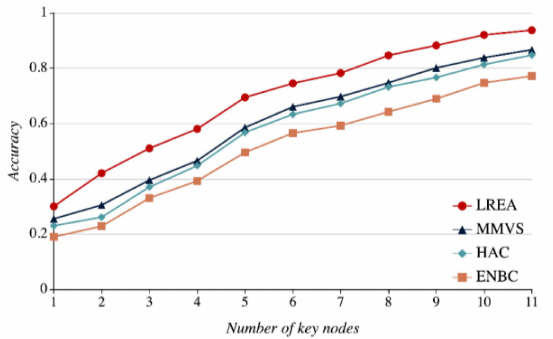
Figure 19. Relations between the number of key nodes and evaluation accuracy rates.